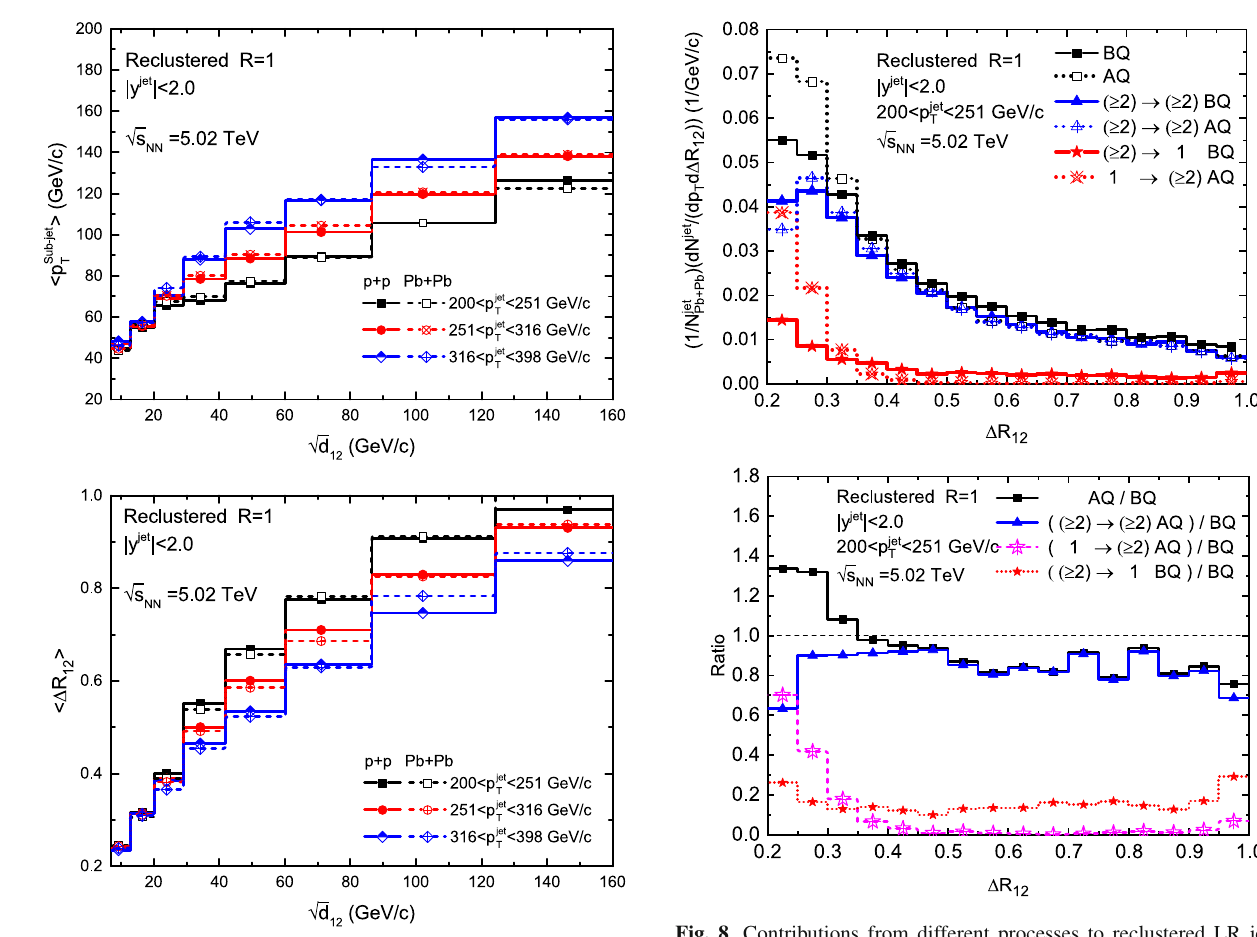
Fig. 7 Average energy of the hardest splitting in different reclustered jet transverse momentum intervals in p + p and Pb + Pb collisions as a function of the splitting scale (top panel). The angle of the hardest splitting in different reclustered LR jet transverse momentum intervals in p + p and Pb + Pb collisions as a function of the splitting scale at √ s NN = 5 . 02 TeV (bottom panel)